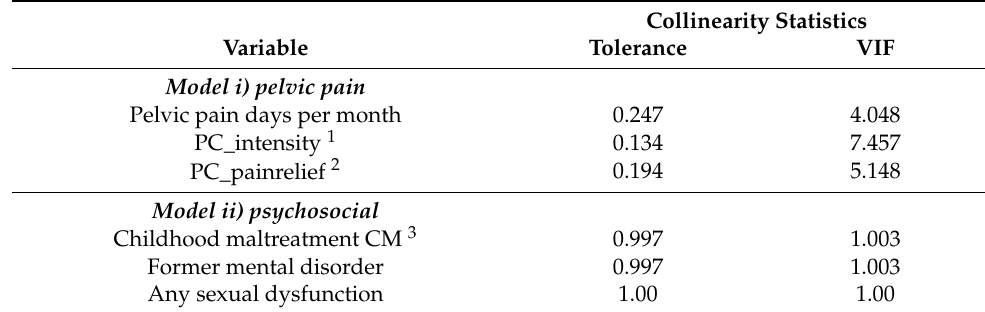
Table A2. Results of collinearity diagnostics for models i) pelvic pain and ii)